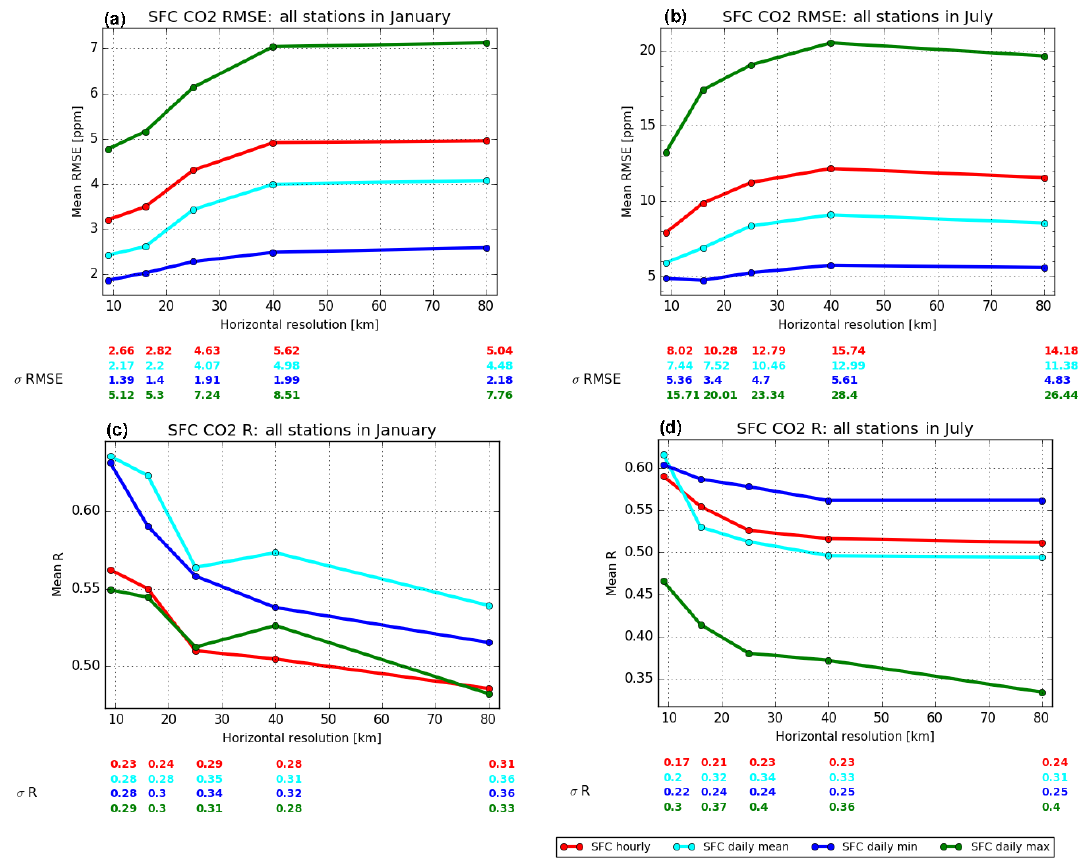
Figure 5. Mean RMSE of near-surface CO 2 (ppm) (a, b) and Pearson’s correlation coefficient R (c, d) at different model resolutions in January (a, c) and July (b, d) for all 51 stations (see Table A1). The standard deviation of the plotted variable from each station is shown by the numbers below the horizontal resolution for each temporal resolution (hourly, daily mean, daily min and daily max). All the model simulations are based on the 1d forecast. Note that different scales are used in each